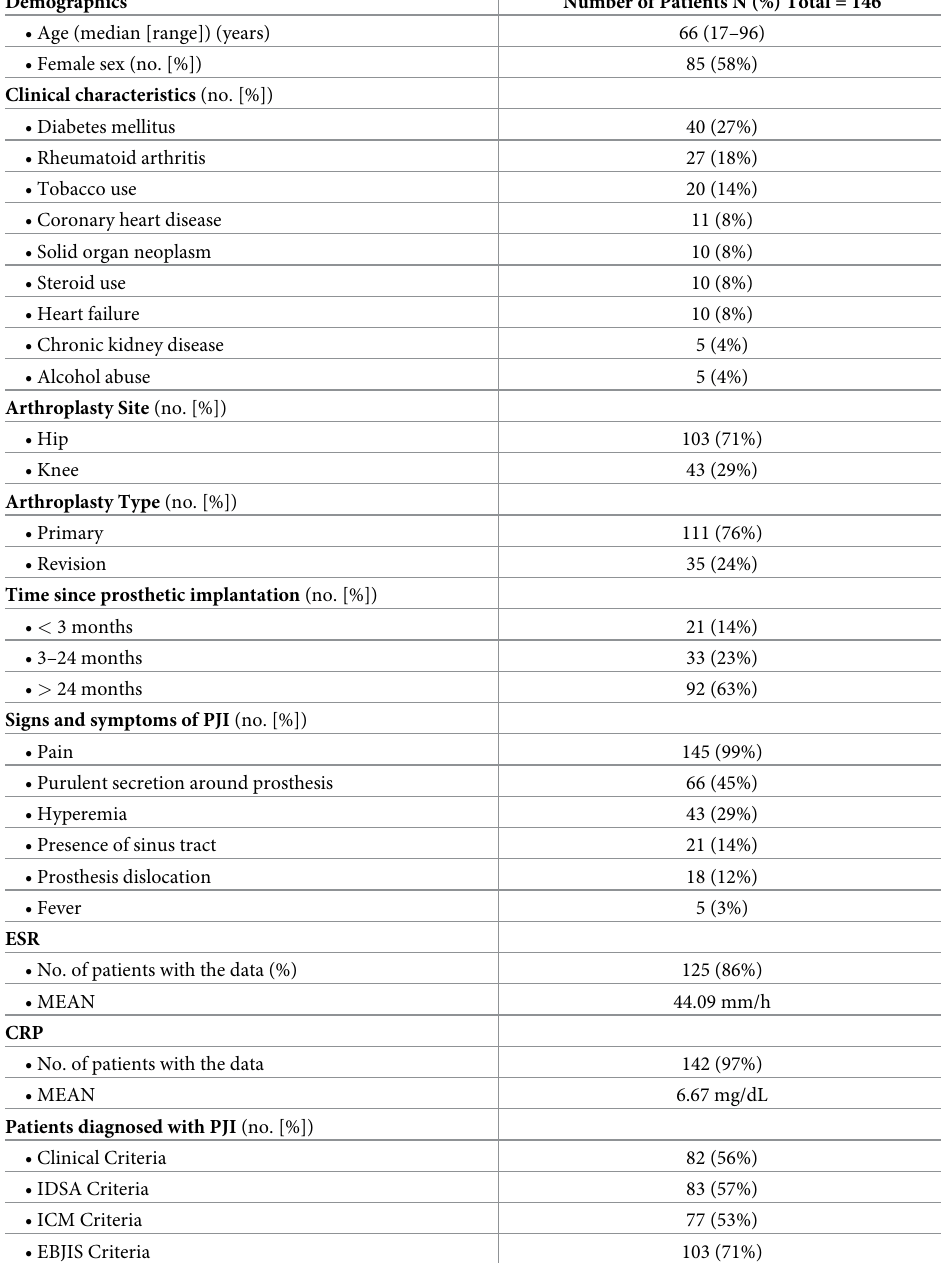
Table 1. Demographics, clinical characteristics and number of patients diagnosed with PJI according to different criteria (clinical, IDSA, ICM and EBJIS) among 146 patients undergoing prosthetic joint